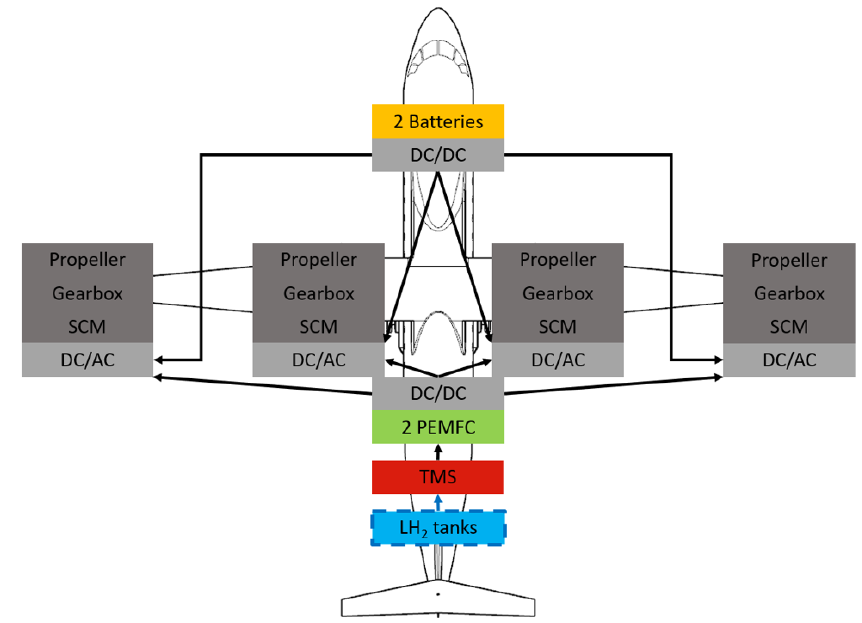
Figure 6. Powertrain component arrangement within HAIQU.